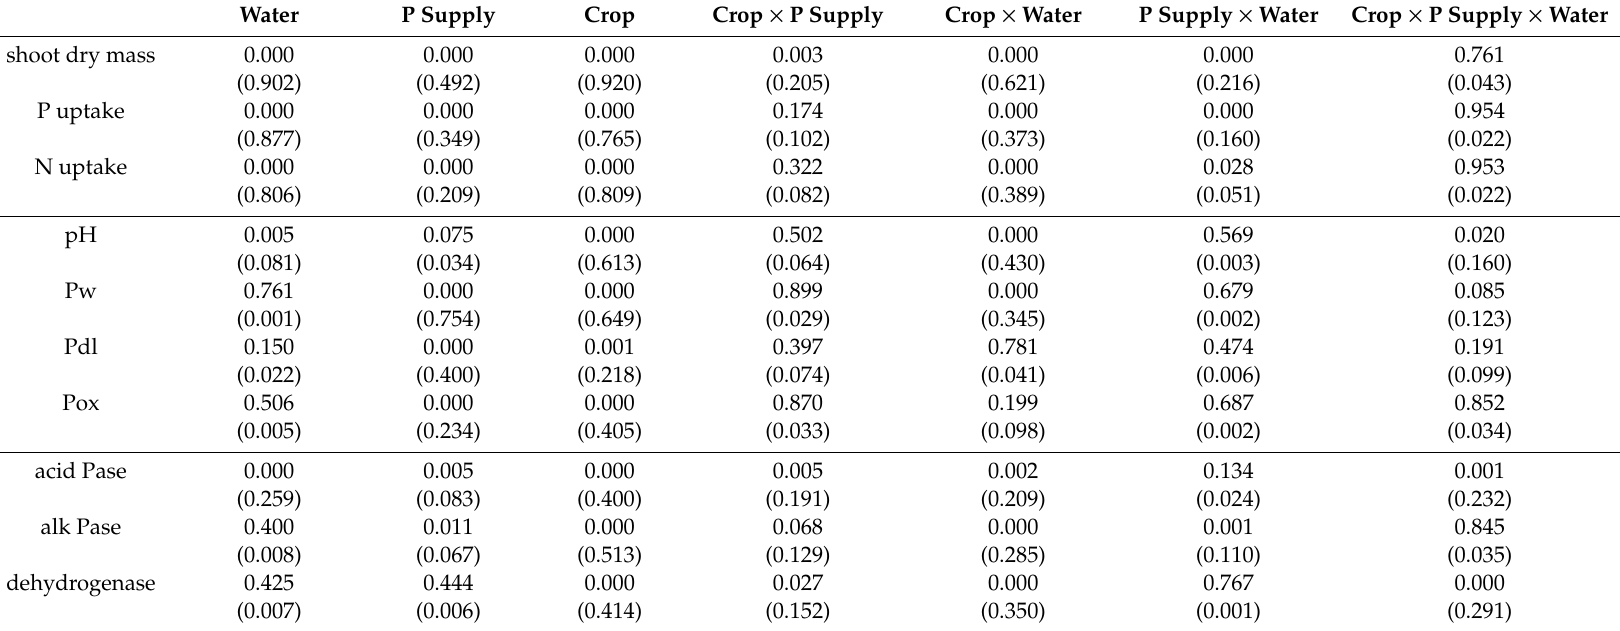
Table A2. Single and interactive e ff ects of water supply, phosphorus supply and cropping (ANOVA, p -values and e ff ect size (eta 2 in brackets) in the Water-P-Trial. Water P Supply Crop Crop × P Supply Crop × Water P Supply × Water Crop × P Supply × Water shoot dry mass